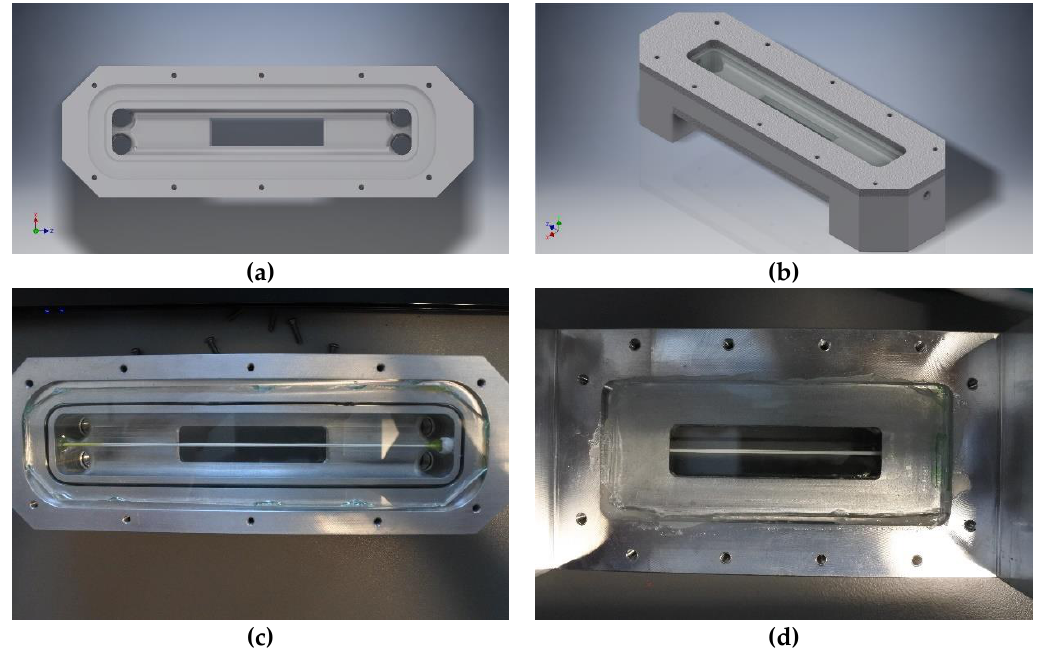
Figure 2. Three dimensional renderings of filtration cell without ( a ) and with ( b ) glass and mounting plates and pictures of disassembled ( c ) and assembled filtration module ( d ) with membrane.